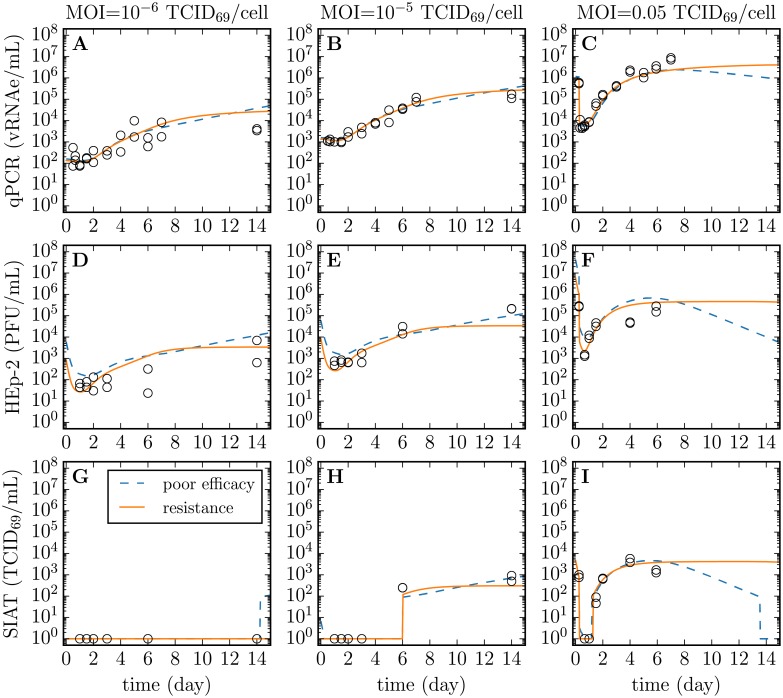
Time course of the parametrized in silico MM for the in vitro infection of SIAT cells with RSV A Long.Parameters of the in silico MMs (lines) Eqs (9)–(11) were estimated by simultaneously considering all data from Fig 4 (circles) for the total RSV yield quantified via qRT-PCR (A, B, C), and the RSV infectious titer quantified both on HEp-2 (D, E, F) and SIAT (G, H, I) cells, of supernatant samples collected from experimental infection of SIAT cells, performed in duplicate, at 3 different MOIs (3 different columns). The blue lines correspond to the poor infection efficacy MM, Eqs (9) and (10), while the orange line corresponds to the infection resistance MM, Eqs (9)–(11), wherein infectivity is assumed to be zero (β = 0) a time τF post-infection.